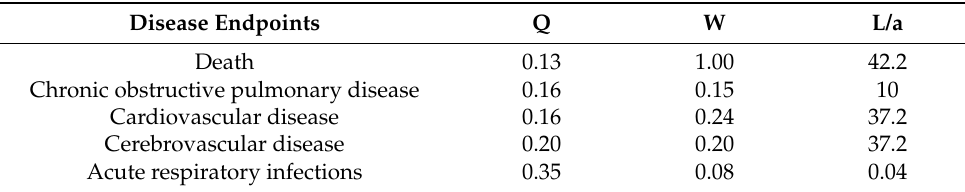
Table 2. Health damage parameter values.